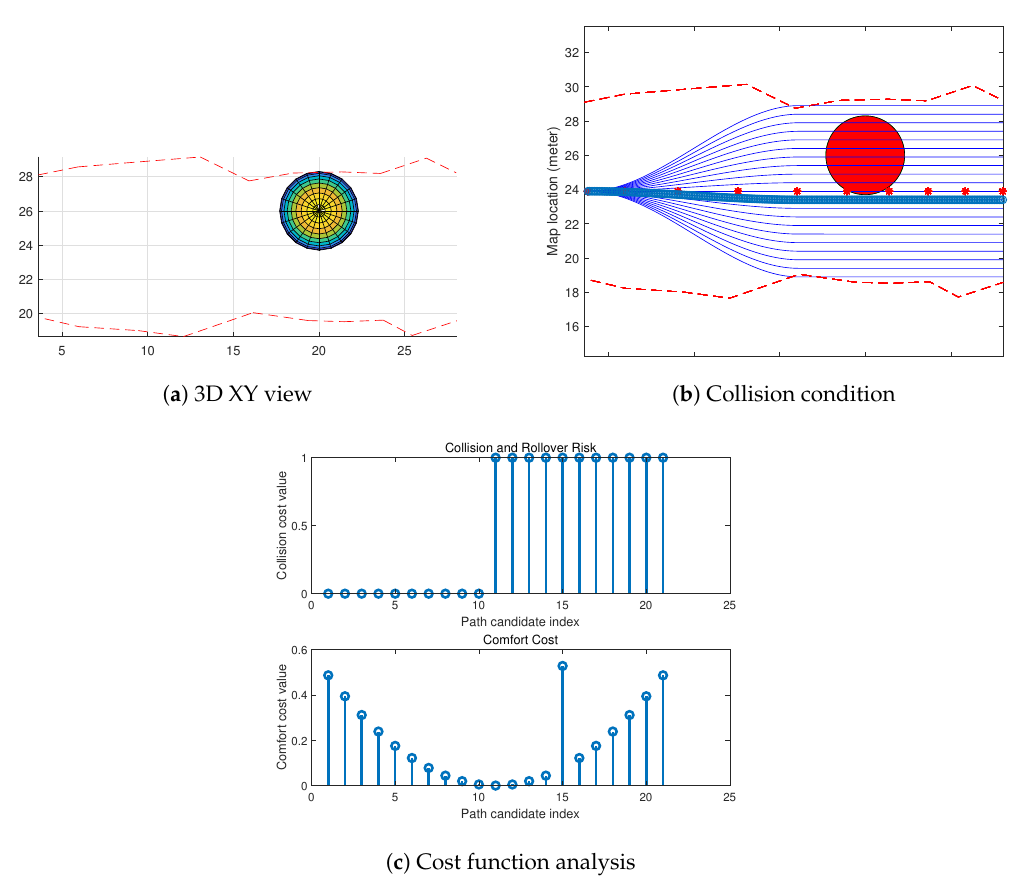
Figure 8. Single obstacle path selection: ( a ) an XY view on obstacles; the light color indicates z > 0, and the dark color indicates z < 0; ( b ) path candidate selection under a single obstacle situation; ( c ) path candidate collision and rollover cost analysis and comfortability cost analysis histogram. All path candidates are presented by multiple solid blue lines; the baseline is presented by red stars; and the obstacles are represented as circles. For obstacles that can cause collision risk, the color of the circles is filled with red; for those that can cause rollover risk, the color is set as green; and for those that are safe to pass through, transparent circles. The selected path candidate in our simulation is presented as the bold solid blue